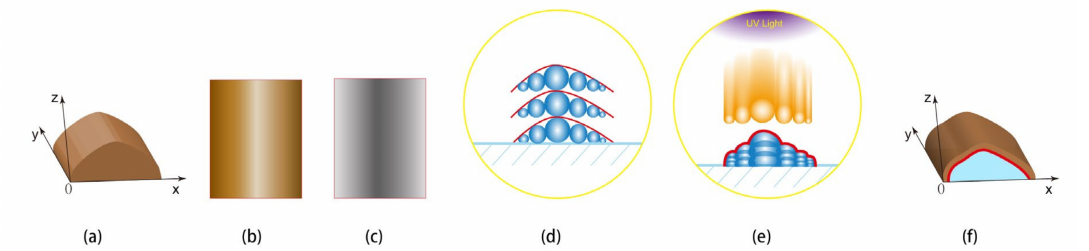
Figure 9. Printing marquetry designing on MDF: ( a ) square digital printing marquetry board with installation notch, ( b ) details of printing 3D wood texture, and ( c ) replicated wood marquetry.